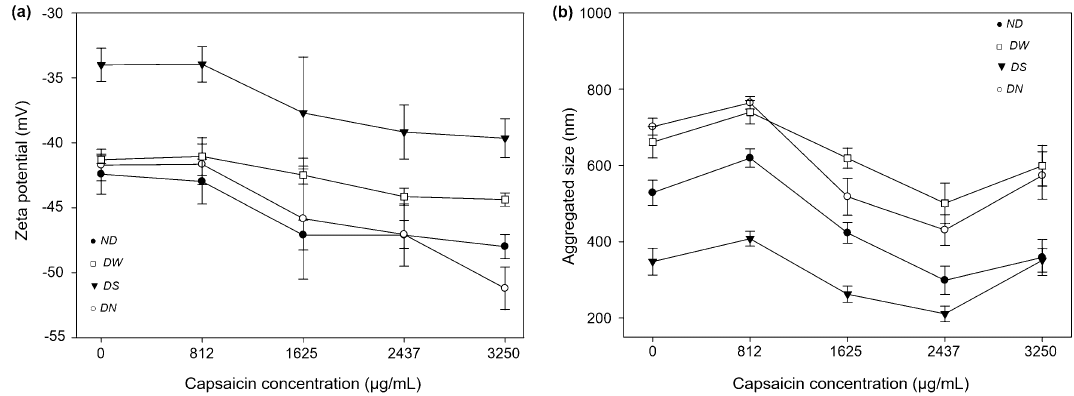
Figure 6. ( a ) The ζ-potential of BSA-capsaicin nanoparticles showed an increase in the electronegativity associated with drying treatments. ND, DW, and DN treatments showed a negative effect, at 3250 µg mL −1 the saturation of capsaicin produces a significant increment of the ζ-potential. While the DS treatment showed a low increase of electronegativity due to the controlled reorganization of the amino acids and capsaicin molecules on the surface of nanoparticles. ( b ) The size of the aggregates of BSA-capsaicin nanoparticles showed an oscillatory behavior associated with drying treatments. Not drying (ND), dried with water (DW) and dried with NaCl (DN) treatments showed a negative effect. In all treatments 812 µg mL −1 of capsaicin produces a significant increment of the size of aggregates. The treatment dried with sucrose (DS) showed a protective effect and reduce the increment of size. Values are means of three experimental replicates ± standard In contrast to the Ed parameter, the shape factor ( Sf , related to circularity) and aspect ratio ( Ar , related to ellipticity) showed only small changes against capsaicin concentration for DW, DN, and DS treatments, see empty squares, empty circles and full triangles in Fig. 5b,c. On the other hand, samples with no drying treat- ment, ND, showed affectations with the concentration as can be seen in Fig. 5b,c, full circles; thus, the change of shape was related to the drying process. This means that the particles not dried show gradual changes of Sf and Ar associated to an increment of capsaicin concentration. Also, interestingly, the treatment with sucrose (DS) resulted in the shape factor closest to 1, i.e. rounder particles, and the lowest aspect ratio, i.e. less ellipticity as can be seen in the full triangles of Fig. 5b,c. This is related to less aggregation and branching as a consequence of reduction in the coalescence. A possible explanation for our results with the sucrose excipient is that when it is incorporated into the colloidal system, it could exert pressure to reduce the surface of contact between the BSA molecules of near nanoparticles due to decrease radius of gyration (spatial expansion), thus inhibiting the unfolding of the BSA in the nanoparticles 26 , and consequently improving the hydrodynamic shape of the NPs. In contrast, the loss of